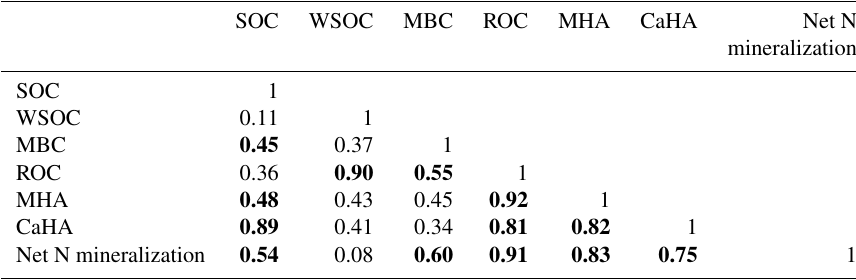
Table 7. Linear correlation coefficients for relationships among different SOM fractions and net N mineralization. SOC WSOC MBC ROC MHA CaHA Net N SOC 1 WSOC 0.11 1 MBC 0.45 0.37 1 ROC 0.36 0.90